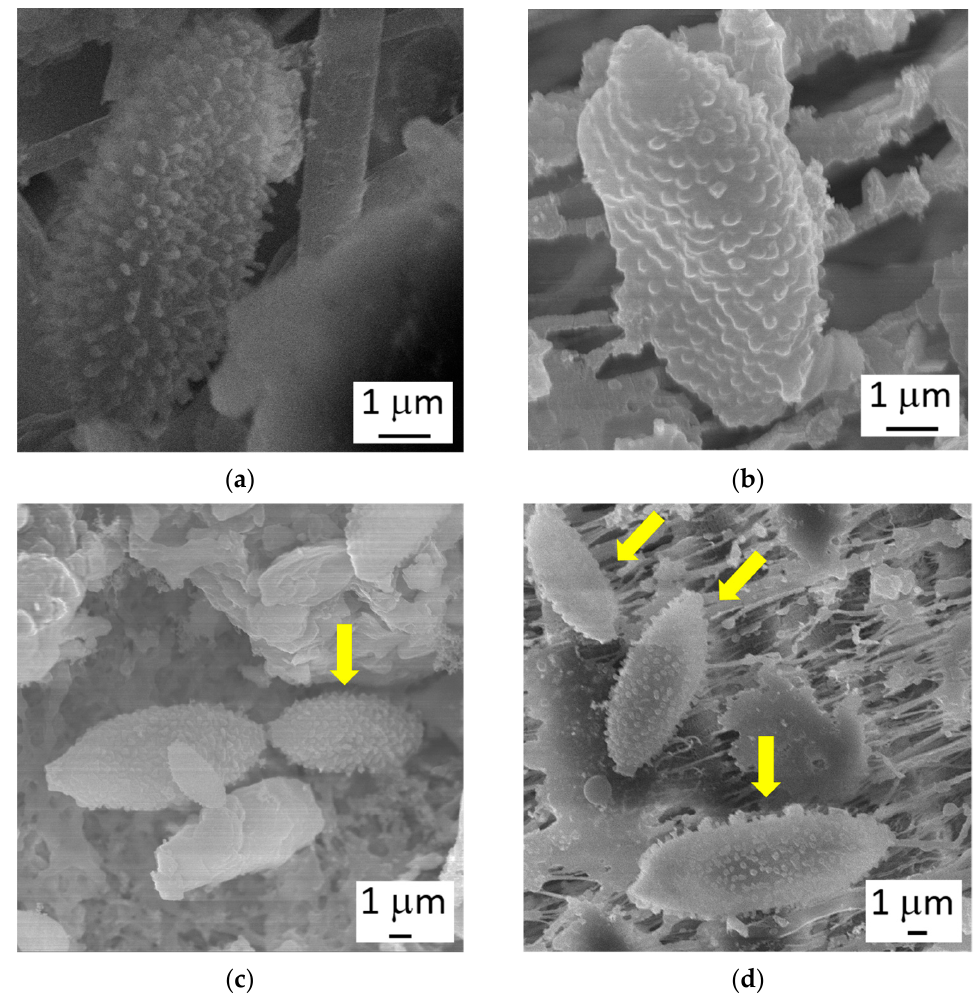
Figure 2. SEM images of fungi conidia found in aerosol samples in summer, Moscow, in different years: ( a )—7 July 2020; ( b )—27 June 2021; ( c )—2 July 2019; ( d )—28 July 2022. Yellow arrows indicates fungi conidia in the figures (c) and (d).